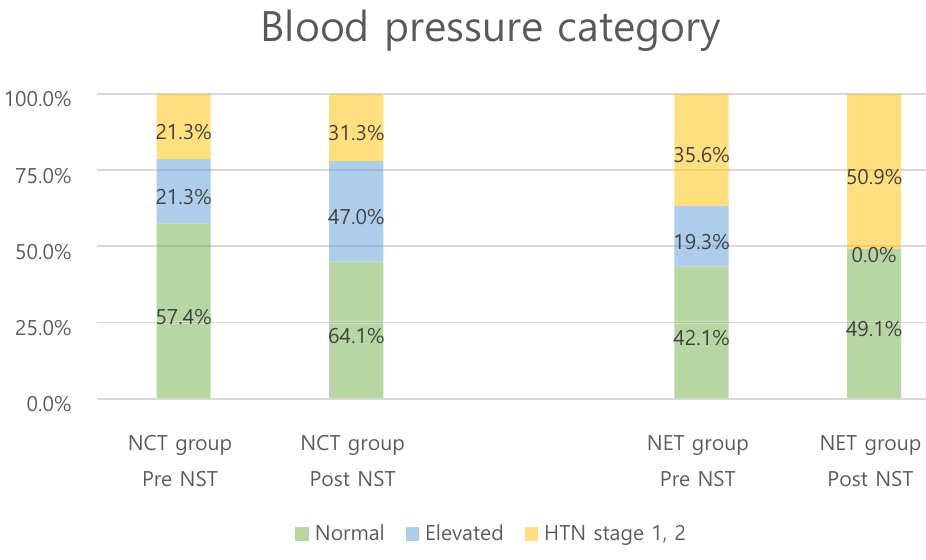
Figure 3. Blood pressure category changes after neoadjuvant treatment.